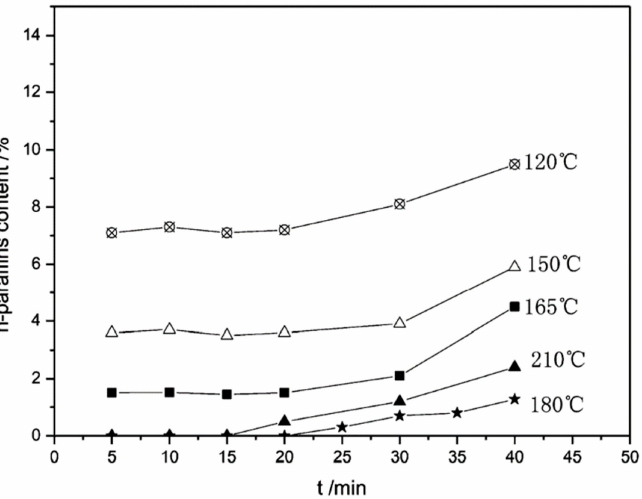
Figure 1. The content (%) of n-alkanes in the raffinate at different temperatures